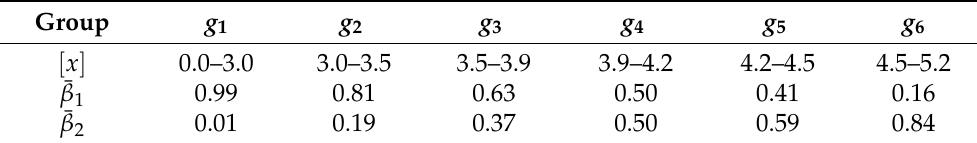
Table 1. Definition of the six groups of roads, g i ( i = 1,6), in terms of the non-acoustic param- ( T ) . Each group has x values within the range indicated in the second row (cf. eter, x = log T 10 Figure 4). The corresponding mean values: ¯ β 1 ( g i ) = P 1 ( ¯ x [ g i ]) and ¯ β 2 ( g i ) = P 2 ( ¯ x [ g i ]) = 1 − ¯ β 1 ( g i ) are indicated in the 3rd and 4th rows, respectively.